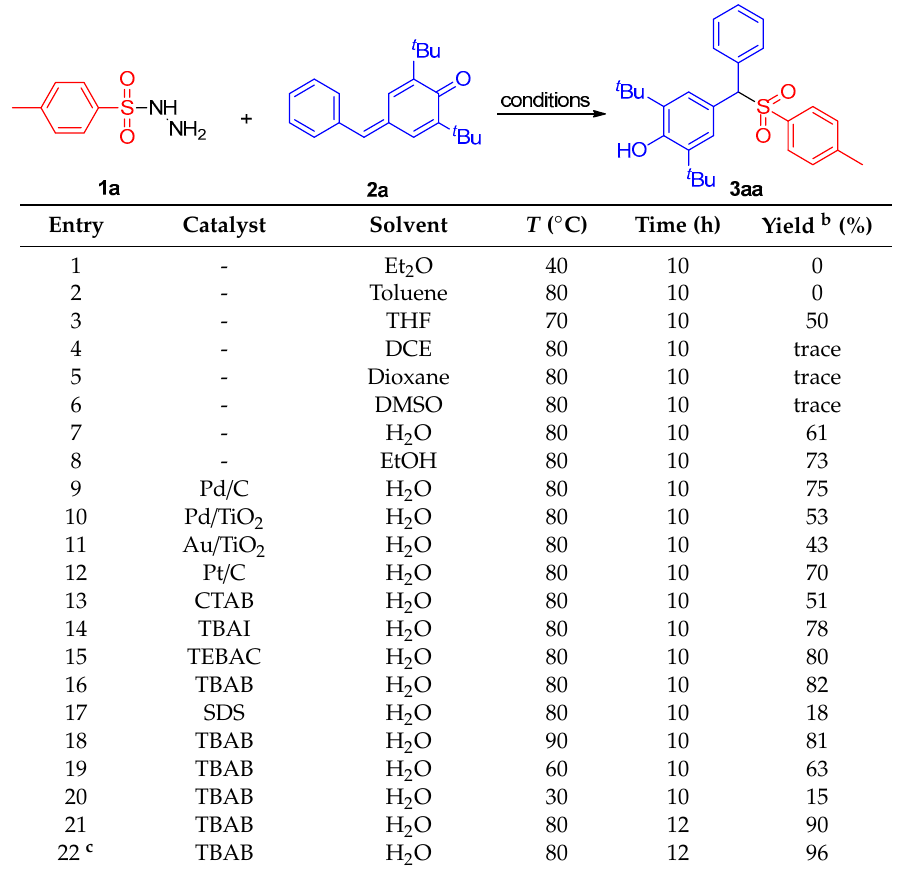
Table 1. Optimization of the reaction conditions for the 1,6-conjugate sulfonylation of 4-methylbenzenesulfonohydrazide 1a to p -QM 2a a .